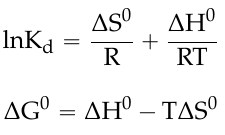
Table 2. Thermodynamic parameters for the adsorption of BPA by GO.